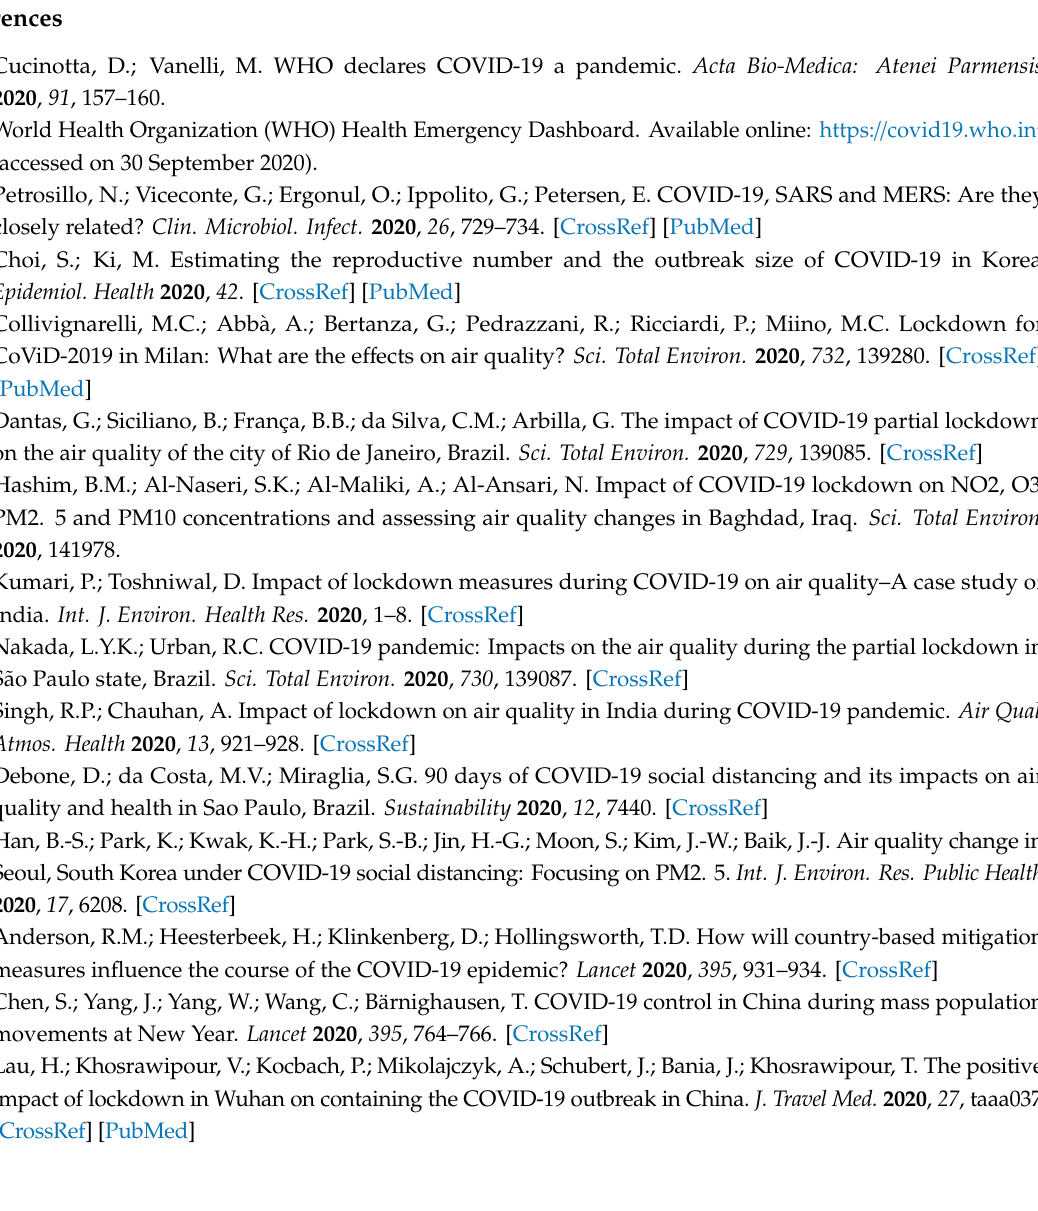
Table S1: Meteorological conditions during COVID-19 pandemic and control periods, Table S2: Relative risks (RRs) and attributable factors (AFs) for PM 2.5 , PM 10 , and NO 2 (Seoul), and Table S3: Relative risks (RRs) and attributable factors (AFs) for PM 2.5 , PM 10 , and NO 2